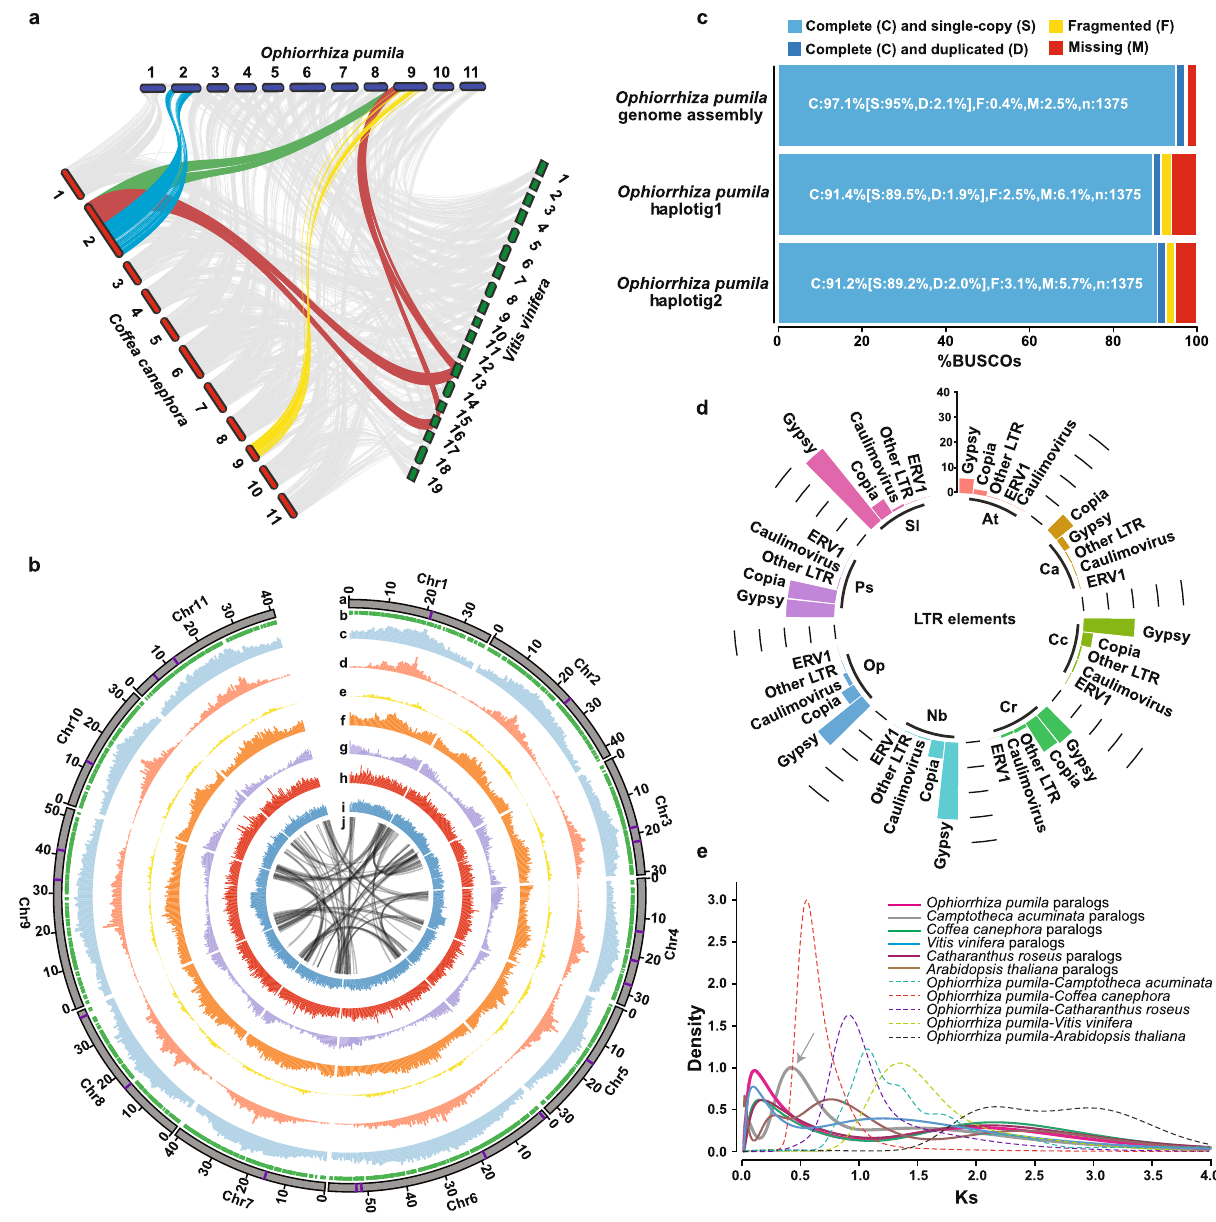
Fig. 3 O. pumila genomic landscape and convergent evolution of monoterpene indole alkaloid biosynthesis. a Synteny blocks between O. pumila , C. canephora , and V. vinifera . Synteny analysis suggested karyotypic rearrangement between chromosomes 2 and 9 of O. pumila and C. canephora genomes, respectively. b Characteristics of the 11 chromosomes of O. pumila . Track a – c corresponds to chromosomes (assembly gap is depicted by purple line at each chromosome), phasing blocks, and repetitive sequences, respectively. Track d – i corresponds to the distribution of long terminal repeat (LTR)-Gypsy, distribution of LTR-Copia, GC density, distribution of predicted gene models, SNP density, and indel density, respectively. Track j corresponds to syntenic blocks. The bar, representing chromosomes, are scaled to chromosome lengths. c Evaluation of O. pumila genome assemblies using Benchmarking Universal Single-copy Orthologs (BUSCO) analysis. d Percentage of genome content comprising LTR elements for eight plant species. At Arabidopsis thaliana , Ca Camptotheca acuminata , Cc Coffea canephora , Cr Catharanthus roseus , Nb Nicotiana benthamiana , Op O. pumila , Ps Papaver somniferum , Sl Solanum lycopersicum . e Synonymous substitution rate (Ks) distribution plot for paralogs and orthologs of O. pumila with other eudicots as shown through colored continuous and dotted lines, respectively. The arrow highlights the recent whole-genome duplication identi fi ed in C. acuminata genome. Source data are provided as a Source data fi